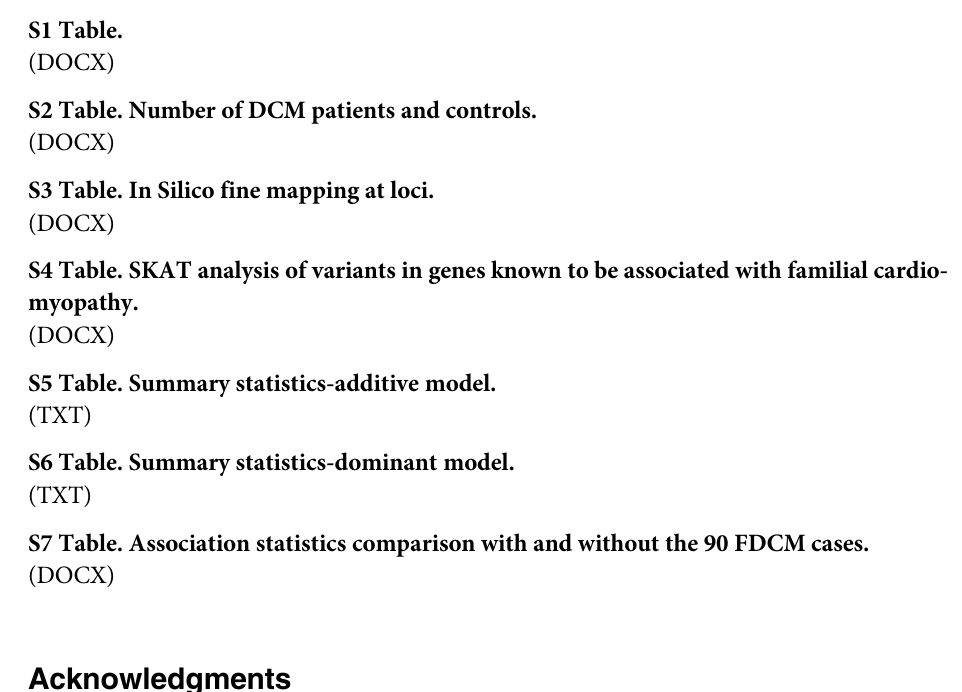
S2 Table. Number of DCM patients and controls. S3 Table. In Silico fine mapping at loci. S4 Table. SKAT analysis of variants in genes known to be associated with familial cardio- myopathy. S5 Table. Summary statistics-additive model. S6 Table. Summary statistics-dominant model. S7 Table. Association statistics comparison with and without the 90 FDCM